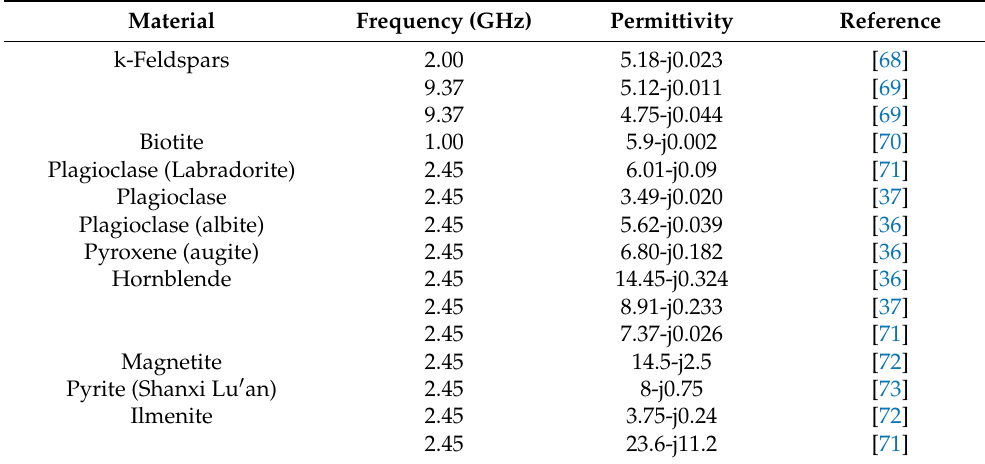
Table 1. Permittivity references of the rock-forming materials of the rock specimens.